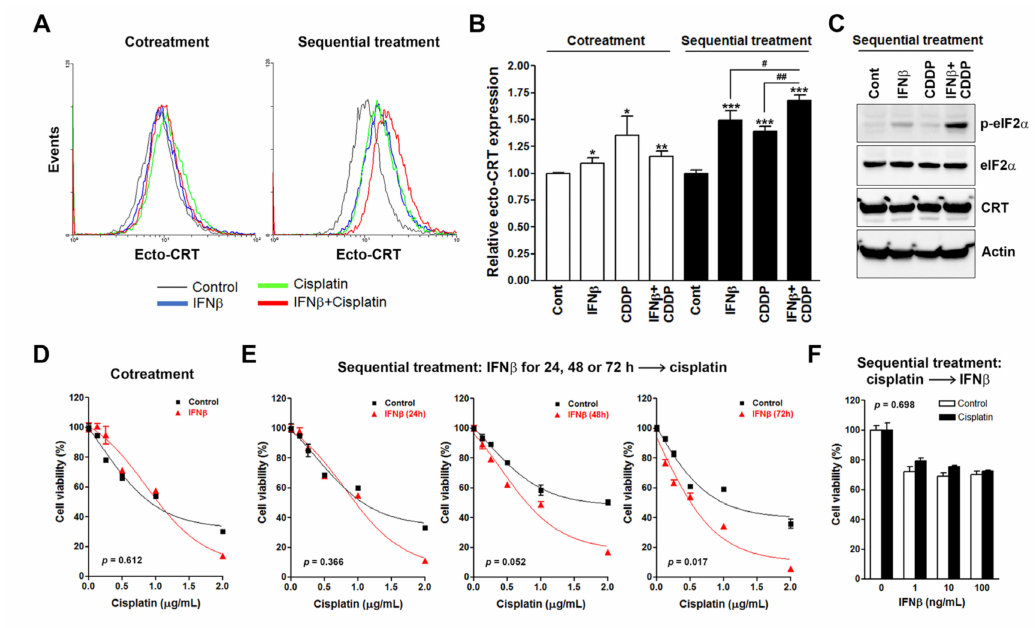
Figure 1. E ff ects of interferon β (IFN β ) and cisplatin treatment protocols on cell viability and surface calreticulin expression in HeLa cells. ( A ) HeLa cells were cotreated with 100 ng / mL IFN β and 2 µ g / mL cisplatin for 24 h, or sequentially treated with 100 ng / mL IFN β for 24 h and 2 µ g / mL cisplatin for another 24 h. Surface calreticulin (CRT) (ecto-CRT) staining was performed and analyzed by flow cytometry. ( B ) The mean fluorescence of ecto-CRT in ( A ) was quantified and plotted. p < 0.05 (* or # ), p < 0.01 (** or ## ) and p < 0.001 (***) indicate significant di ff erences compared to control samples